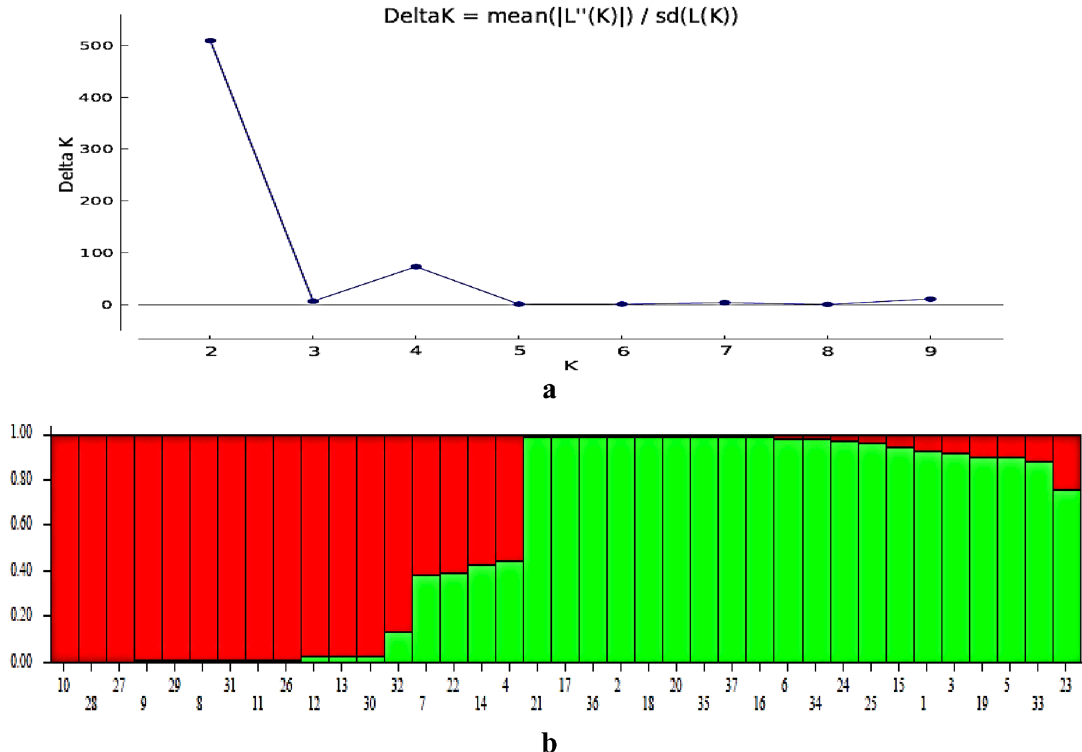
Figure 3. Estimation of the number of groups based on output from STRU CTU RE-software (STRU CTU RE 2.3.4; https:// web. stanf ord. edu/ group/ pritc hardl ab/ struc tures oftwa re/ relea sever sions/ v2.3. 4/ html/ struc ture. html). ( a ) ΔK over K from 1 to 10 with the 8 SSR markers. ( b ) Bar plot showing grouping of 37 genotypes into two different